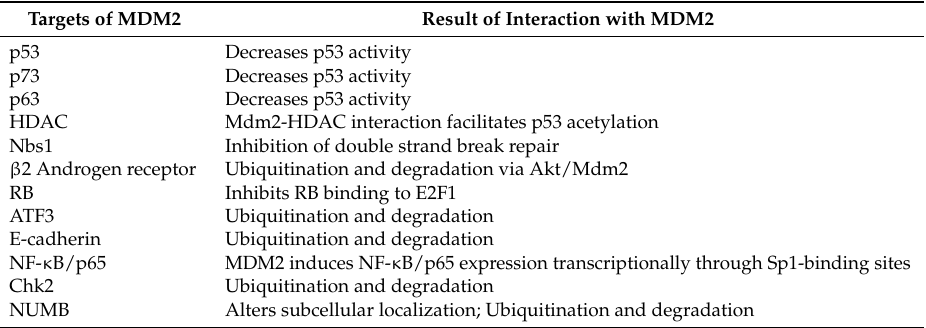
Table 3. Downstream targets of MDM2